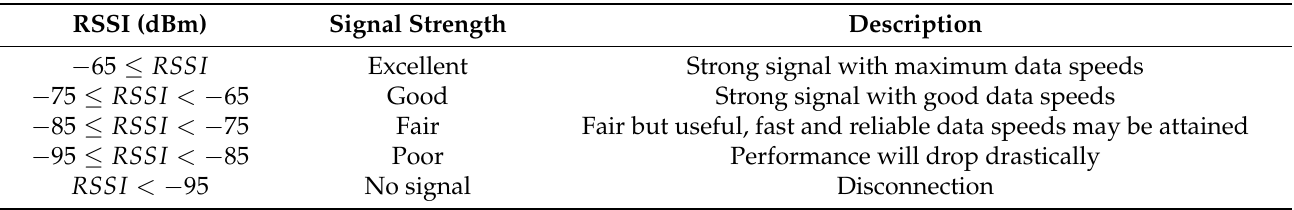
Table A1. Relation between RSSI and